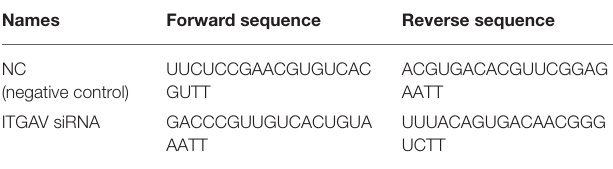
TABLE 1 | List of nucleotide sequence of small interfering RNA.